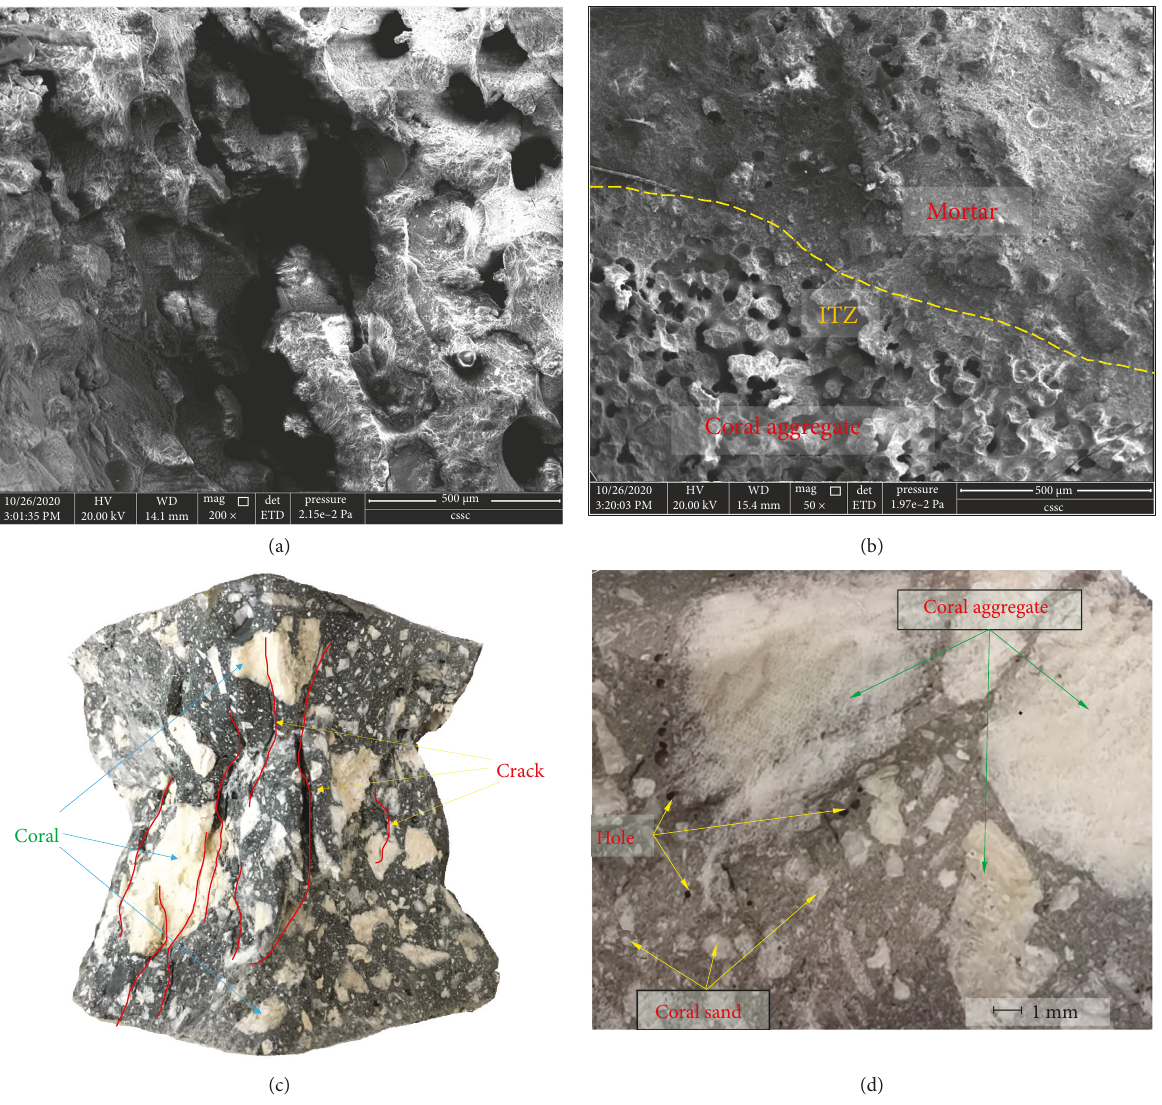
Figure 14: Images of coral concrete. (a) SEM image of coral aggregate. (b) Interface transition zone between aggregate and binder. (c) Failure mode of specimens. (d) Failure section. Table 5: Verification of age strength prediction model for coral